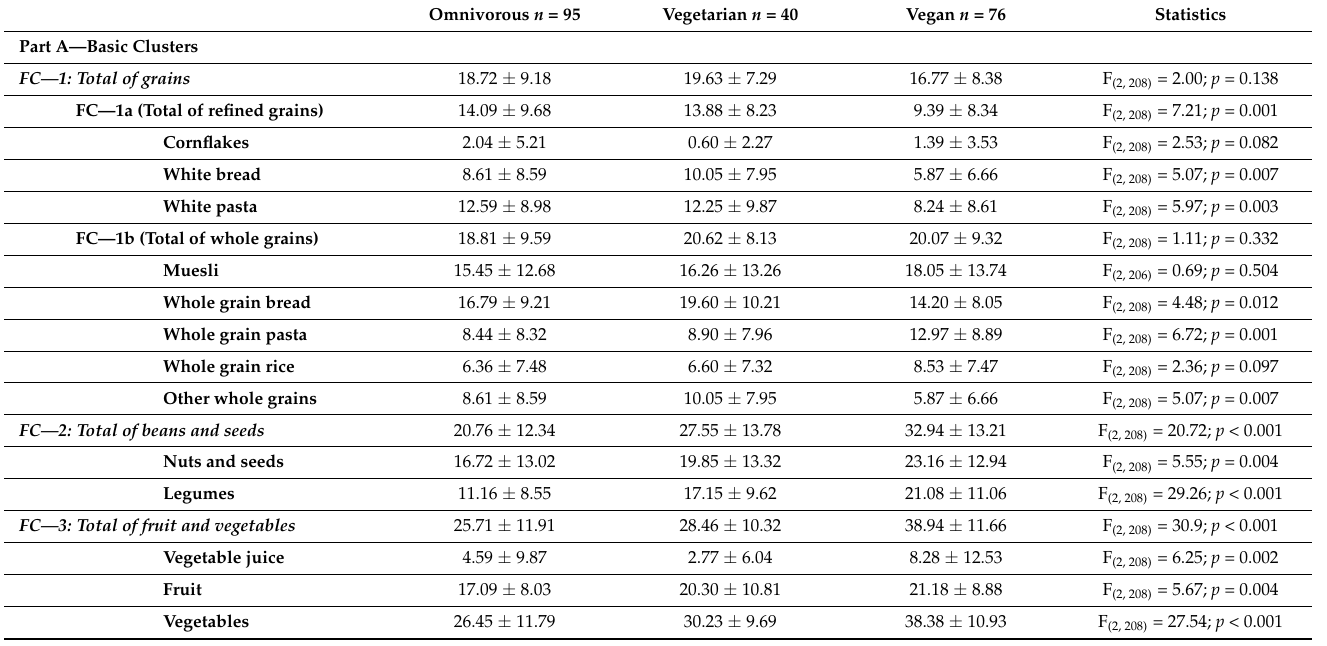
Table 4. Differences between vegan and non-vegan runners in food frequency clusters and